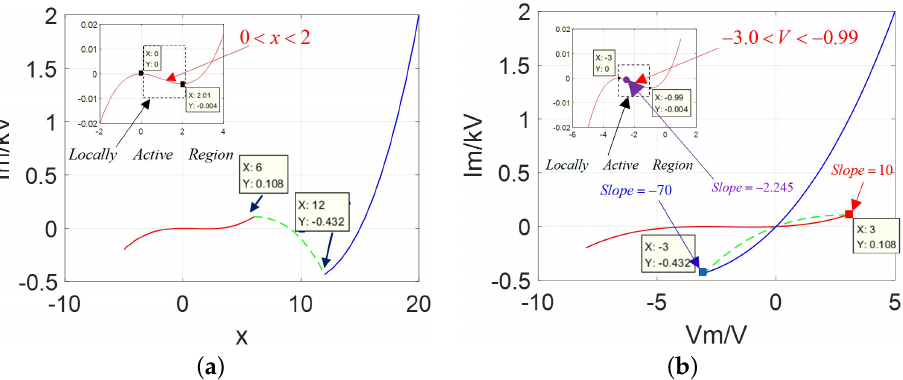
Figure 3. Graphs of current against state variable and DC V − I curve: ( a ) Ivs . X with only one negative slope domain in the first stable branch over the variable range 0 < x < 2; ( b ) Ivs . V with only one negative slope domain over the variable range − 3 V < v < − 0.99